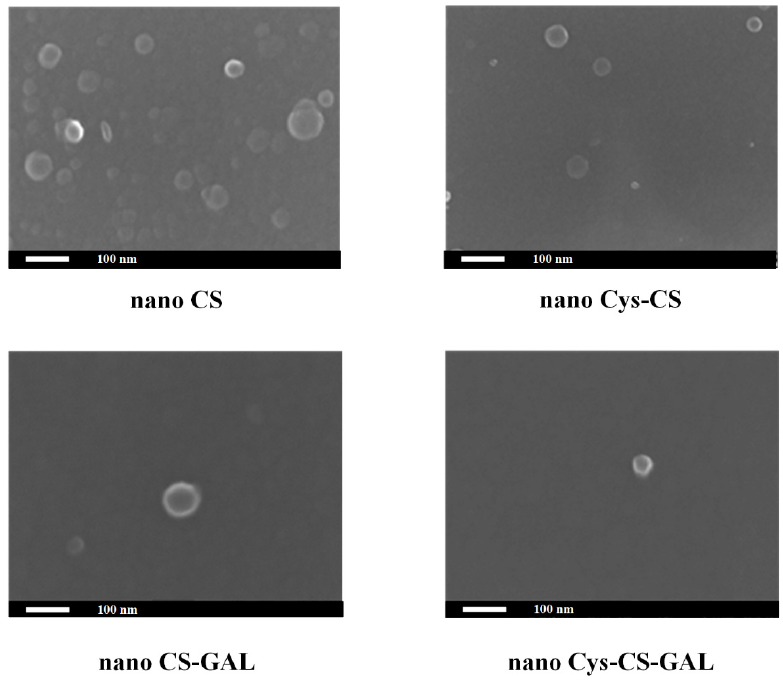
Figure 6. SEM images of neat and drug-loaded CS and Cys-CS NPs. Table 2. Summary of NPs’ PSD, PDI and ζ -potential